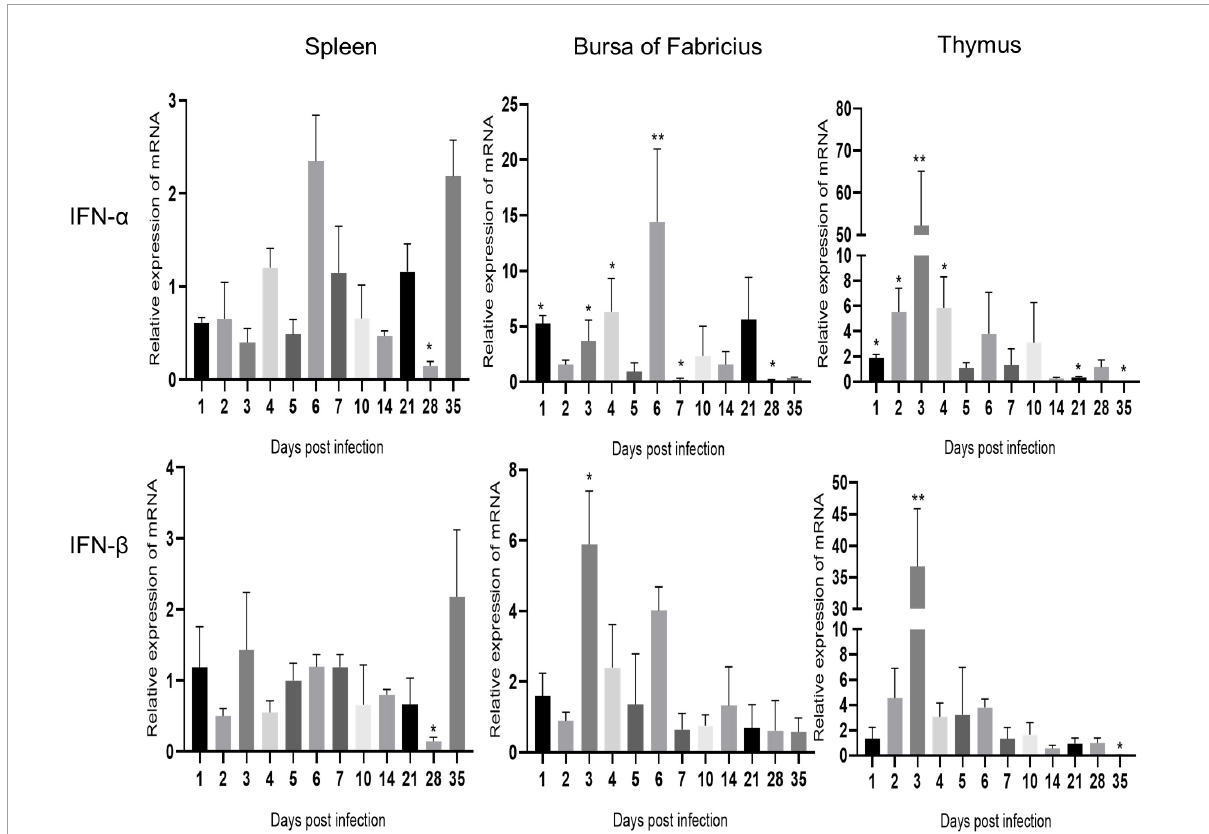
FIGURE4 Changes in IFN transcription levels in the spleen, bursa of Fabricius, and thymus after ARV infection. ARV strain S1133 (10 4 TCID 50 /0.1 ml) was used to infect chickens through the footpad. At 1, 2, 3, 4, 5, 6, 7, 10, 14, 21, 28, and 35 days after infection (dpi), three chickens were randomly collected from each group, and changes in IFN gene expression were analyzed using real-time quantitative PCR. The data are the mean ± SD of three independent experiments. Asterisks indicate significant differences (* P < 0.05, ** P < 0.01).